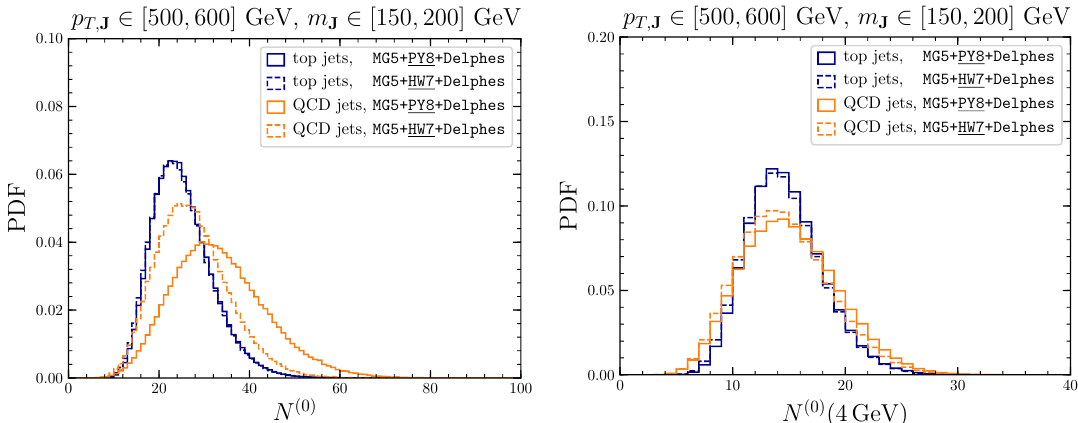
Figure 10. N (0) and N (0) (4 GeV) distributions of PY8 and HW7 data sets. The blue histograms are for the top jets, and the orange histograms are for QCD jets. The solid lines are for PY8 generated samples, and the dashed lines are for HW7 generated